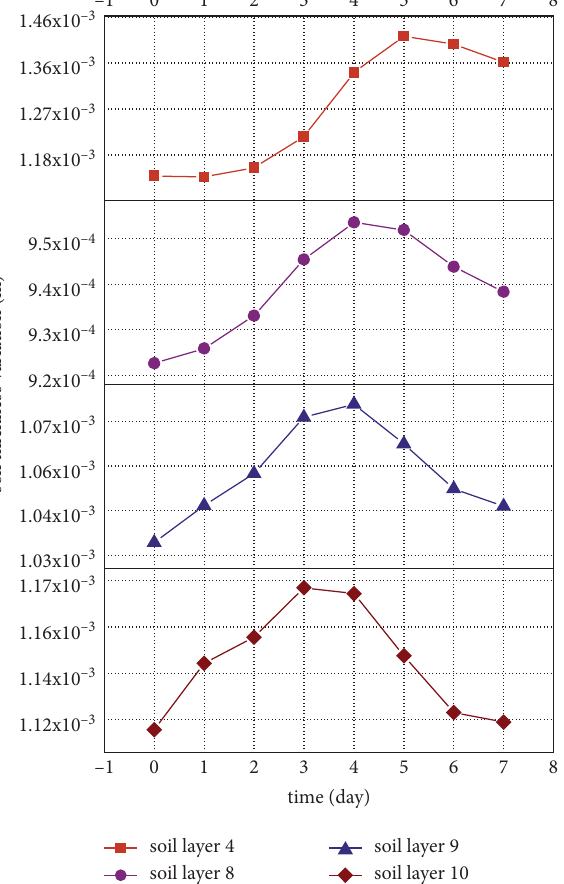
Figure 16: Time-course curve of the change in the thickness of each soil layer at point A of the reinforced soil